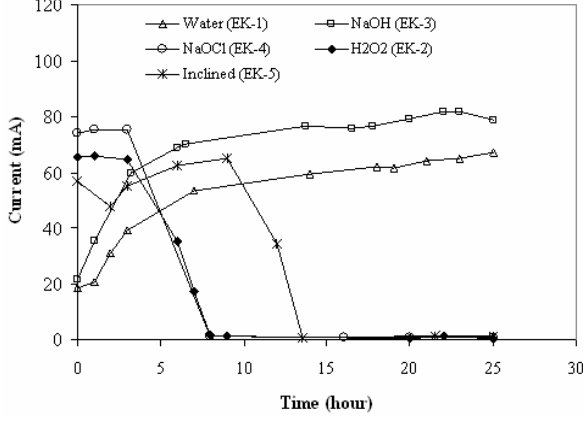
Figure 2: Current vs. Time